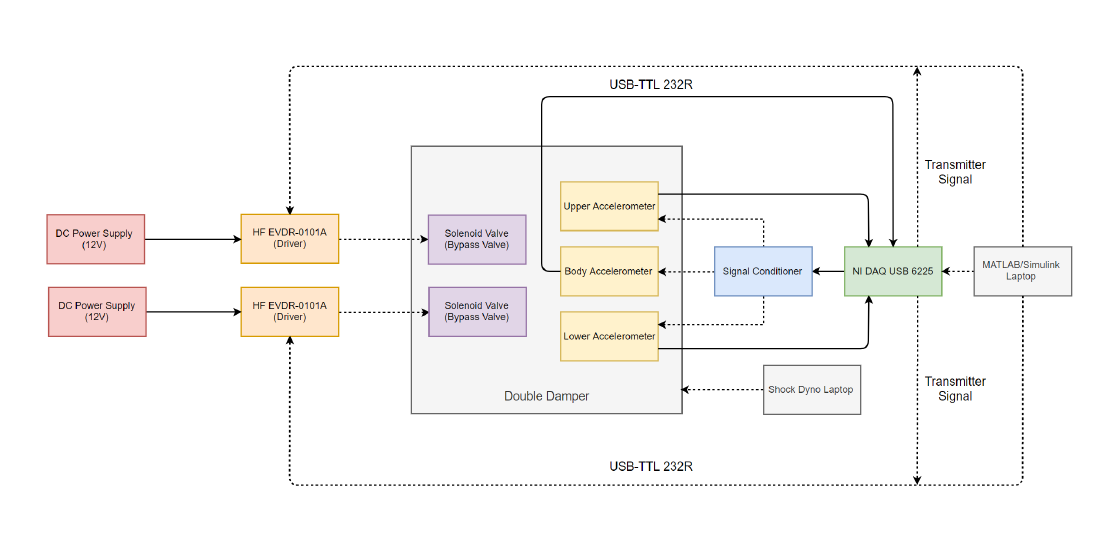
Figure 6. Block Diagram of the experimental setup for testing the Double Damper on Shock